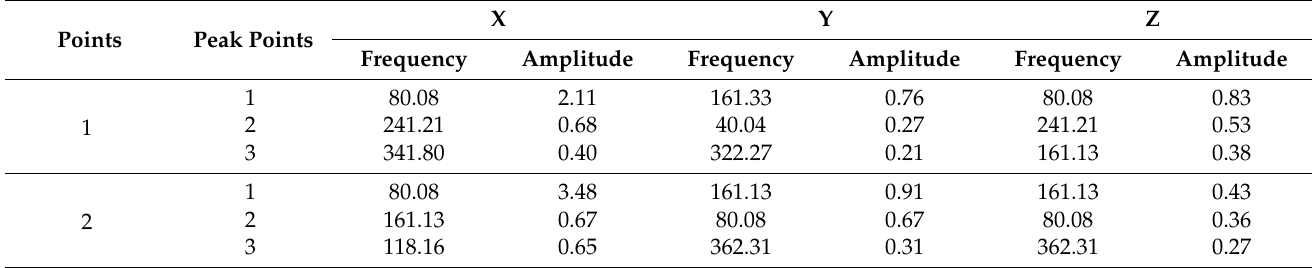
Table 6. Frequency data of rated power revolution condition.